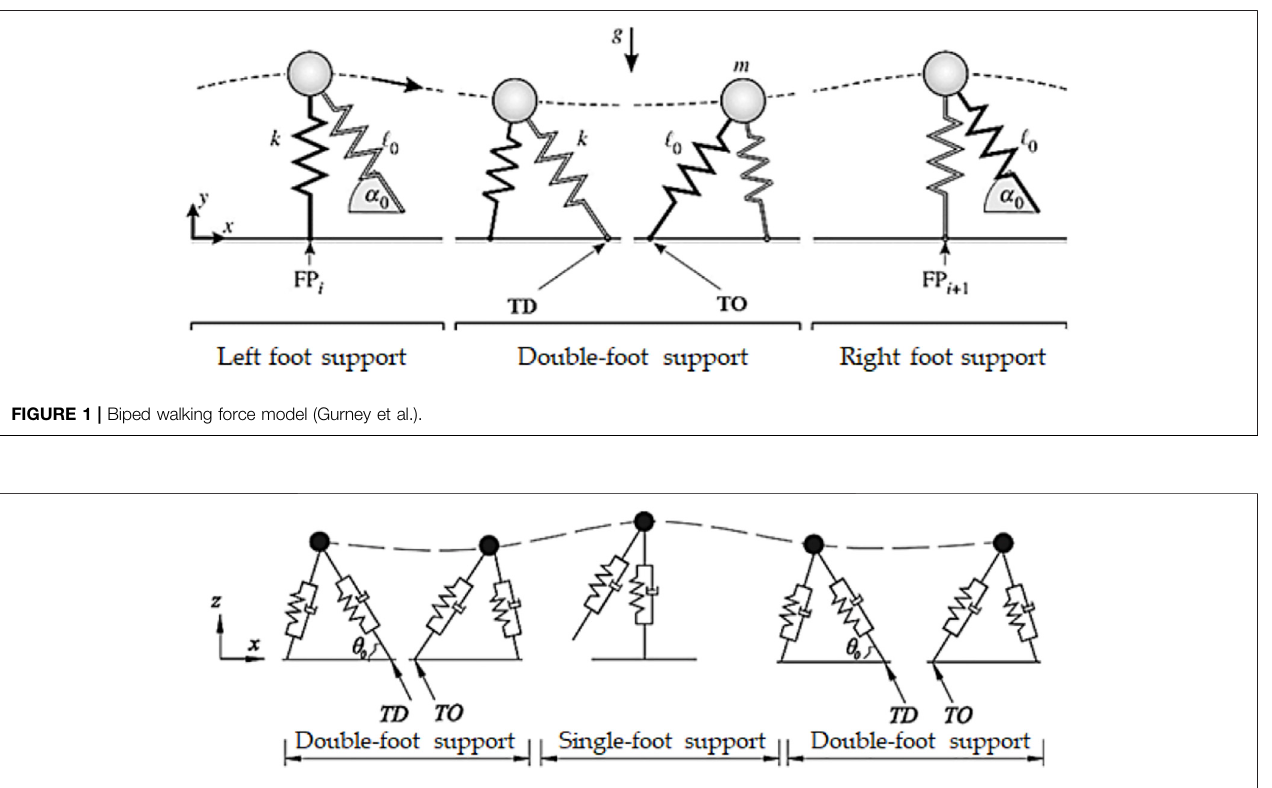
FIGURE 2 | Damped biped walking force model (Chen et